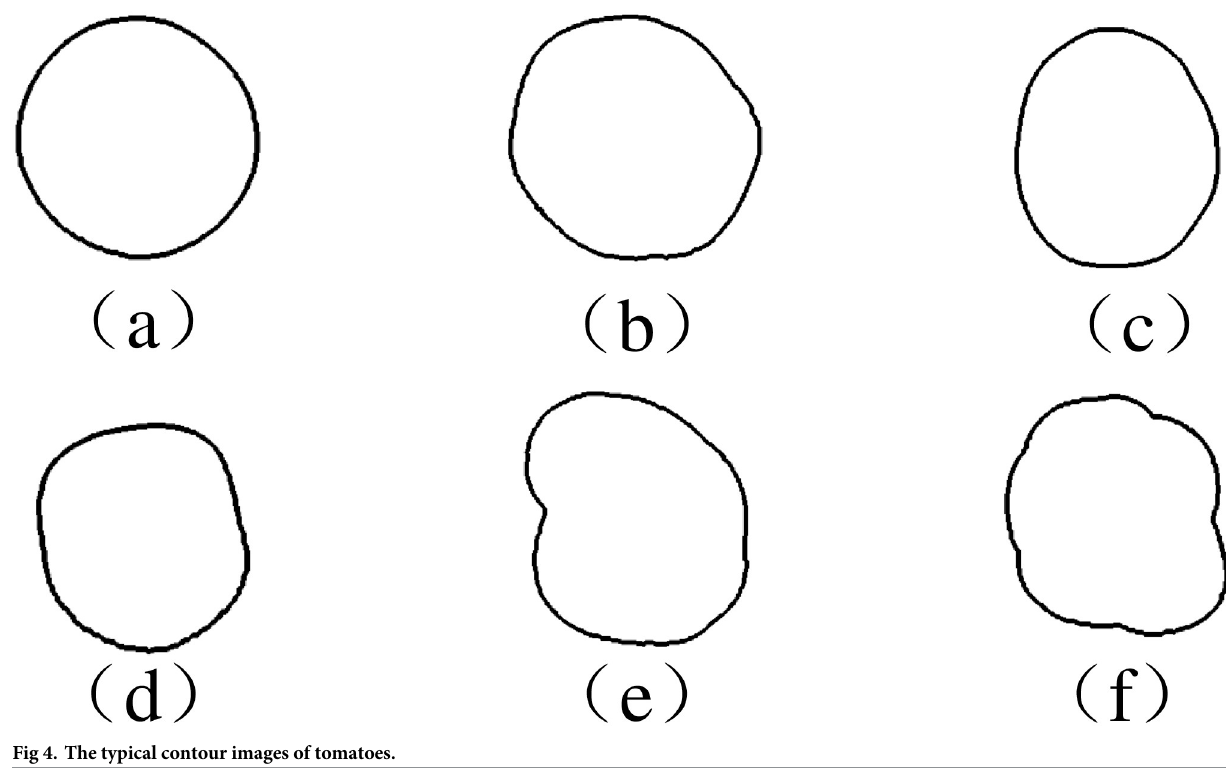
Fig 4. The typical contour images of